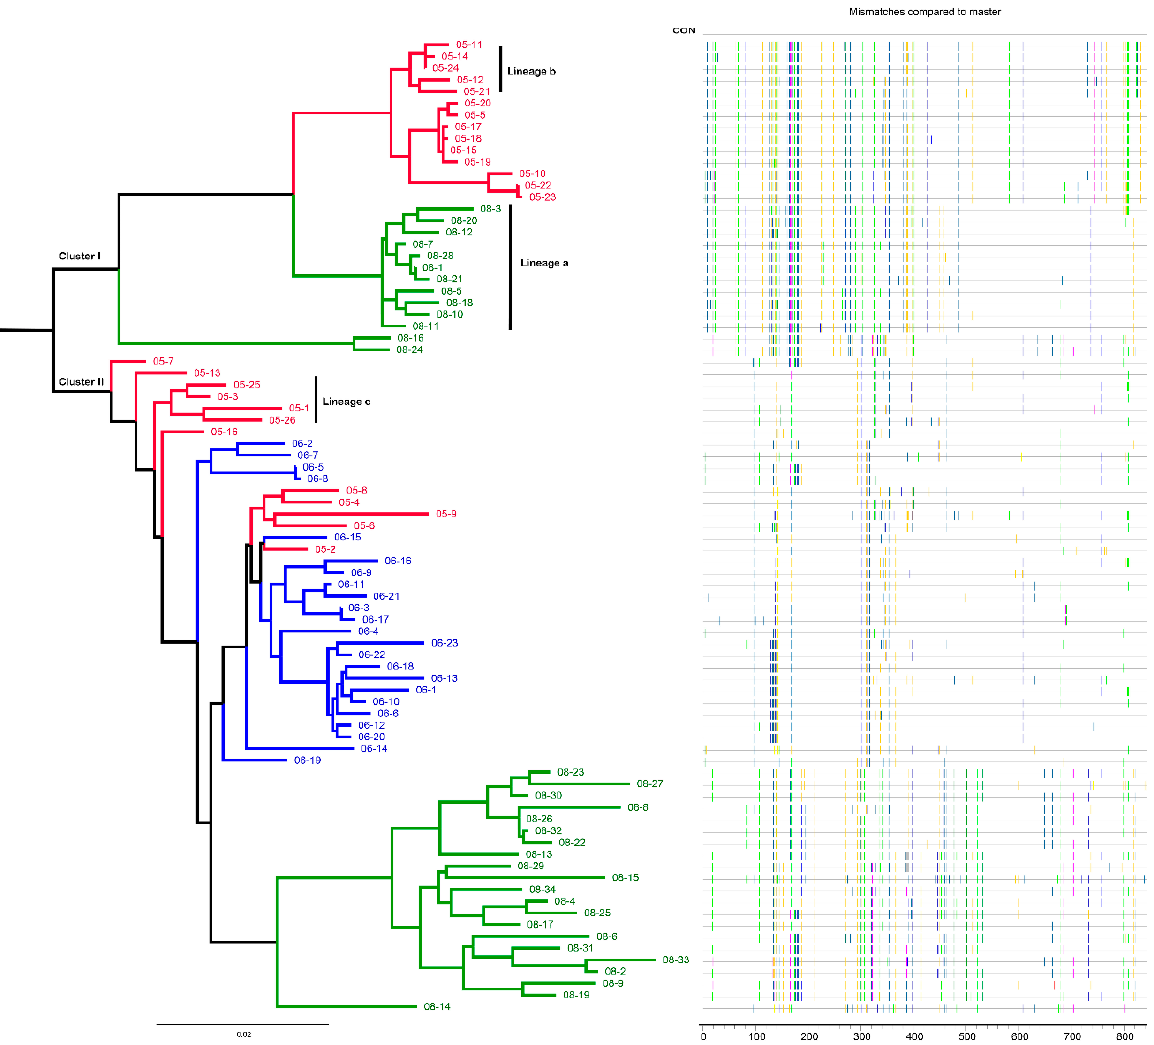
Figure 1. Phylogenetic tree and Highlighter plot of env sequences of CBJC515 from three time points. In the phylogenetic tree, sequences from different sampling time points are highlighted in red (2005), blue (2006), and green (2008), respectively. In the highlighter plot, each line represents an env sequence. The mutations differing from the consensus sequence are color coded according to the amino acid. Lineage a represents a subcluster of 2008 env sequences in Cluster I, lineage b represents a subcluster of 2005 env sequences in Cluster I, and lineage c represents a subcluster of 2005 env sequences in Cluster II. The bar under the phylogenetic tree is the gene distance scale. The scale length (range: 0–1) represents the difference between sequences (range: 0–100%). The x-axis of the highlighter plot indicates the position of the amino acid in gp160.